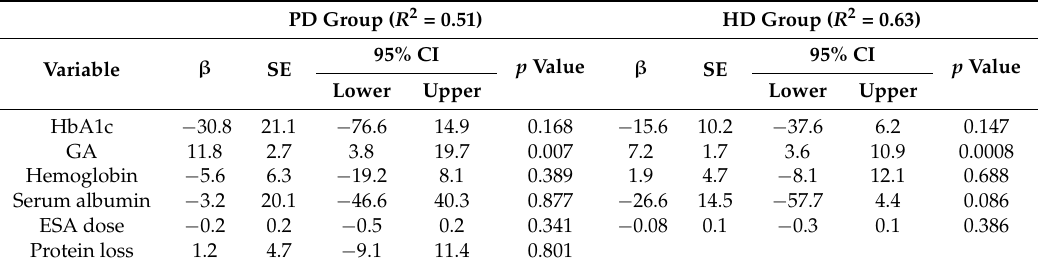
Figure 4. Associations of mean GA level with mean hemoglobin concentration ( A ); mean monthly ESA dosage ( B ); serum albumin level ( C ); and protein loss ( D ) in diabetic patients on dialysis. HD, hemodialysis; PD, peritoneal dialysis. Table 2. Multivariate analysis of clinical factors affecting plasma glucose level in diabetic patients on dialysis. PD Group ( R 2 = 0.51) HD Group ( R 2 = 0.63)